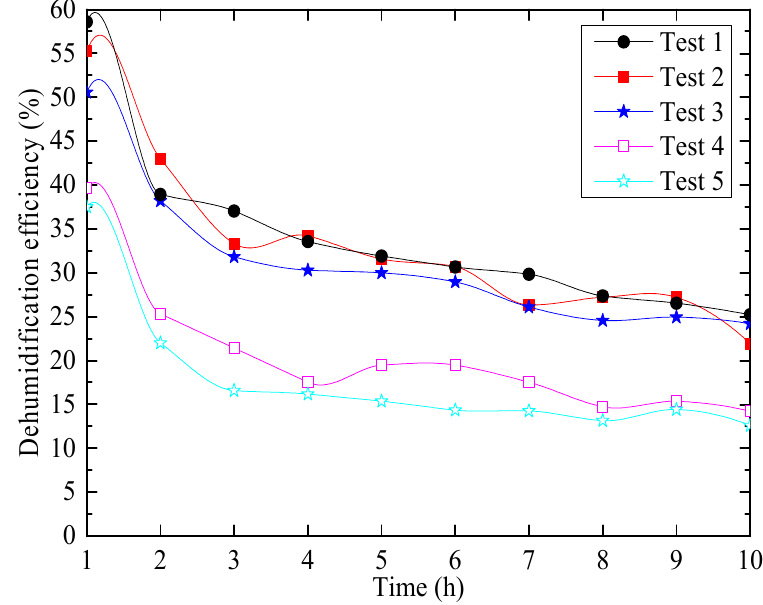
Figure 7. Variation of the dehumidification efficiency of the solid desiccant modules with time.